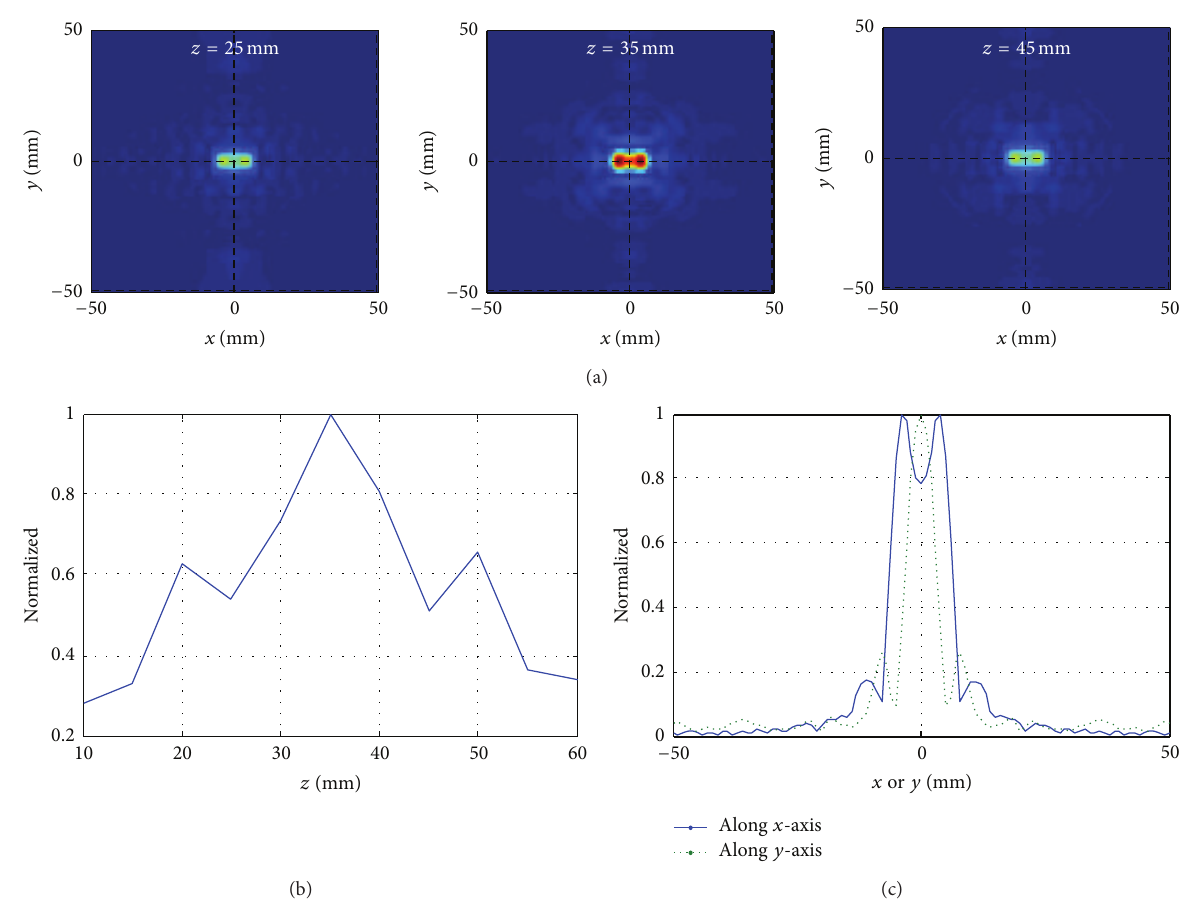
Figure 10: (a) Reconstructed images (shown every 10mm along 𝑧 and only at three range locations) when the distance between the reconstruction planes is Δ𝑧 = 5mm for the example in Figure 6(c). Color bars are the same as in Figure 5. Normalized 1D magnitude of the reconstructed images along (b) range direction ( 𝑧 direction) and (c) cross-range directions ( 𝑥 and 𝑦 directions) in the plane of the objects.